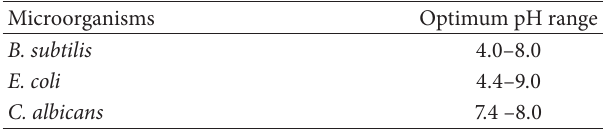
Table 3: Optimum pH range for tested